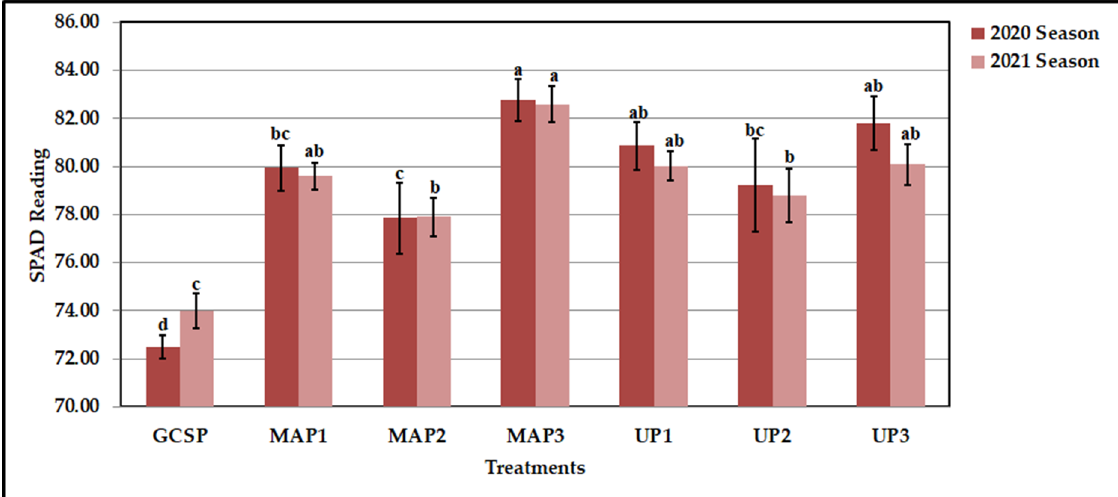
Figure 2. Influence of phosphorus fertilizers; mono-ammonium phosphate (MAP) and urea phos- phate (UP) applied to number of leaves m − 2 of olive (arbequina cv.) trees grown in sandy loam clay soil under multi-abiotic stresses (CaCO 3 = 8.8 vs. 9.2%, ECe = 6.4 vs. 7.2 dS m − 1 , and pH = 7.78 vs. 7.89) during 2020 and 2021 seasons. GSCP applied represents 1.75 kg tree − 1 , MAP 1 , MAP 2 , and MAP 3 represent MAP applied at 0.336, 0.445, and 0.555 kg tree − 1 , and UP 1 , UP 2 , and UP 3 represent UP applied at 0.465, 0.616, and 0.770 kg tree − 1 . Bars in the same years with a different letter indicate significant differences between treatments at p ≤ 0.01. According to Duncan’s multiple range test, bars sharing the same letter in each column are not significantly different.